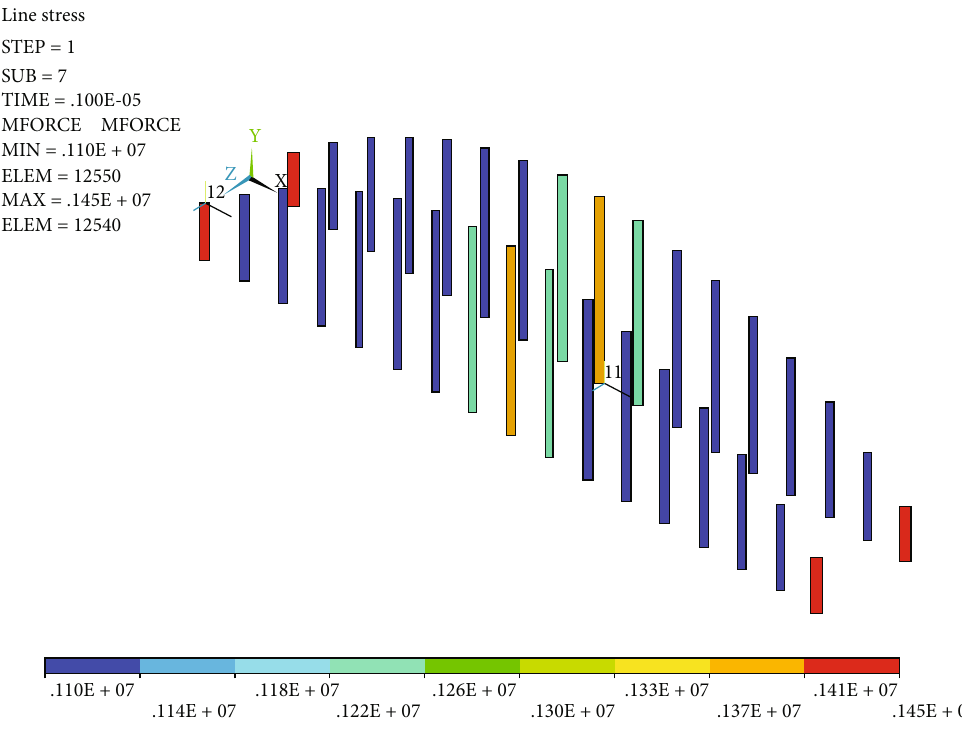
Figure 8: The axial force cloud map of hanger under case 5 (N).